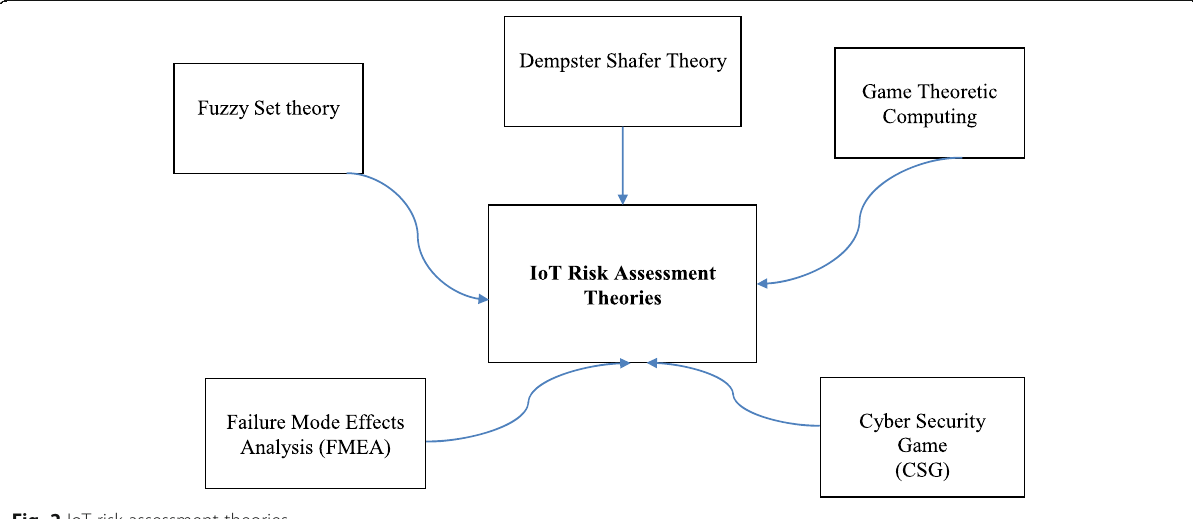
Fig. 2 IoT risk assessment